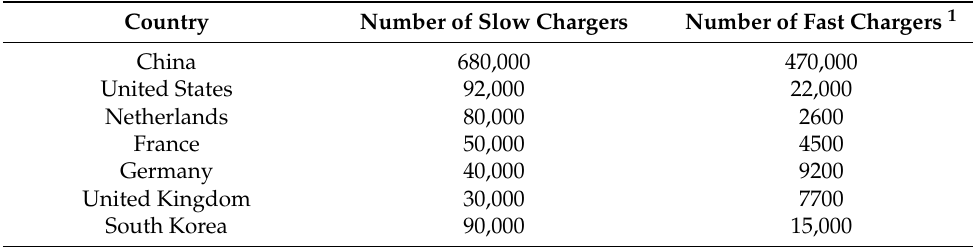
Table 6. Publicly available EV chargers as of 2021